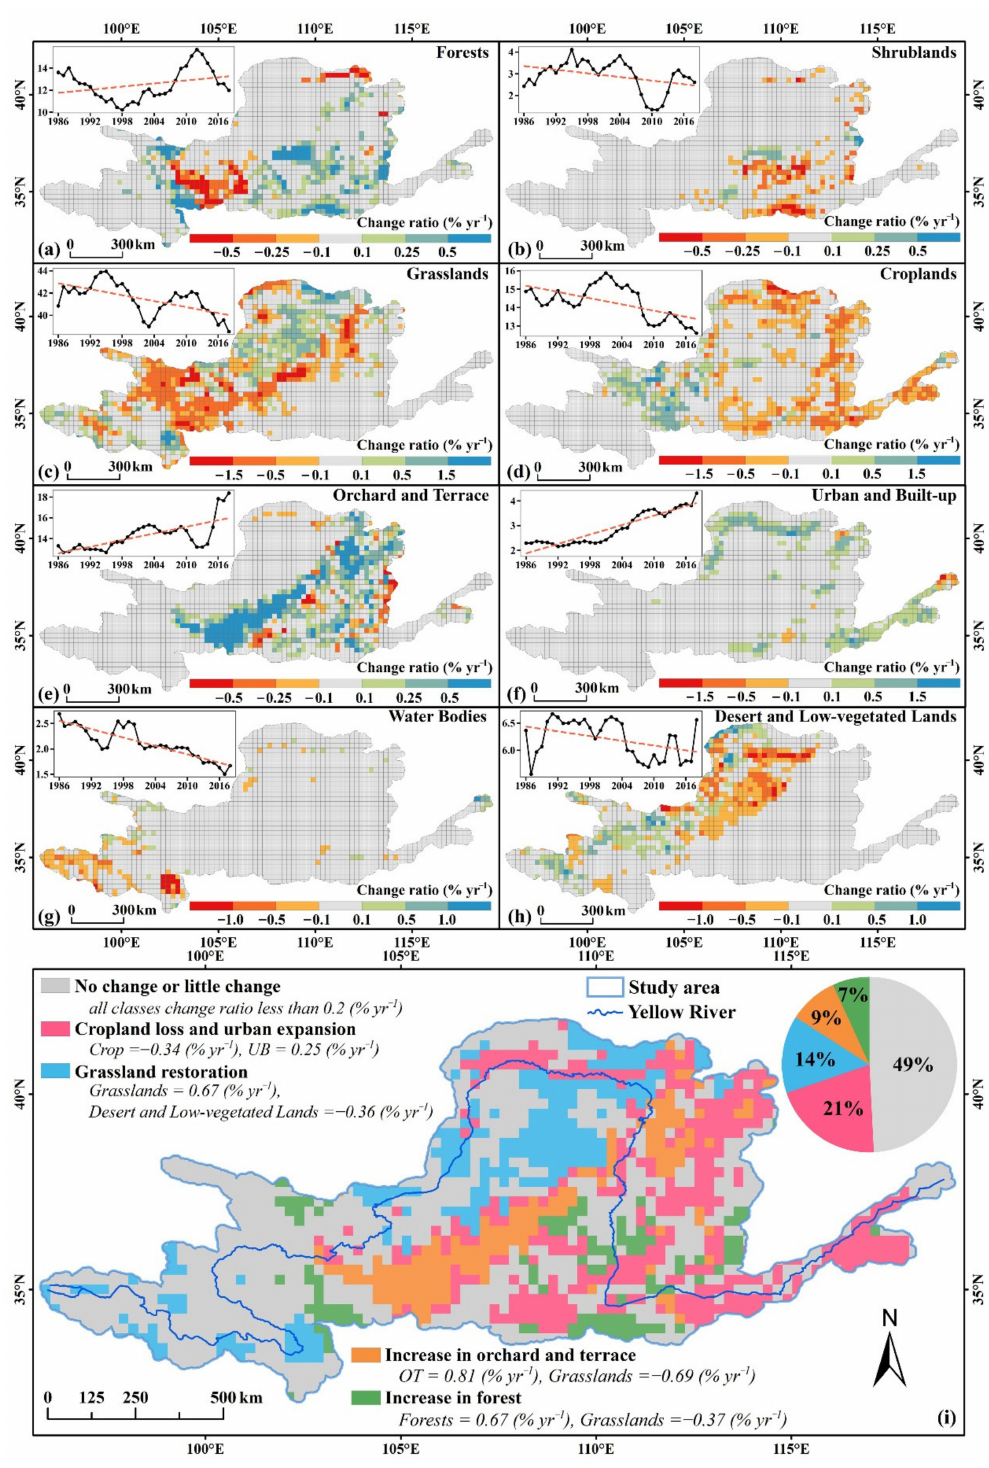
Figure 5. Geographical distribution of the YR basin with significant ( p < 0.05) change in area ratio per year during 1986–2018 for each class: ( a ) forests, ( b ) shrublands, ( c ) grasslands, ( d ) croplands, ( e ) orchard and terrace, ( f ) urban and built-up, ( g ) water bodies, and ( h ) desert and low-vegetated lands. Grey grids show the areas with a statistically insignificant change slope or change ratio below 0.1 % y − 1 ( − 0.1 to 0.1). Insets in each graph show the annual area (10 4 km 2 ) of each class from 1986 to 2018. ( i ) Geographical distribution of five LUCC patterns in the YR basin. Italic indicates the average change rate of the corresponding